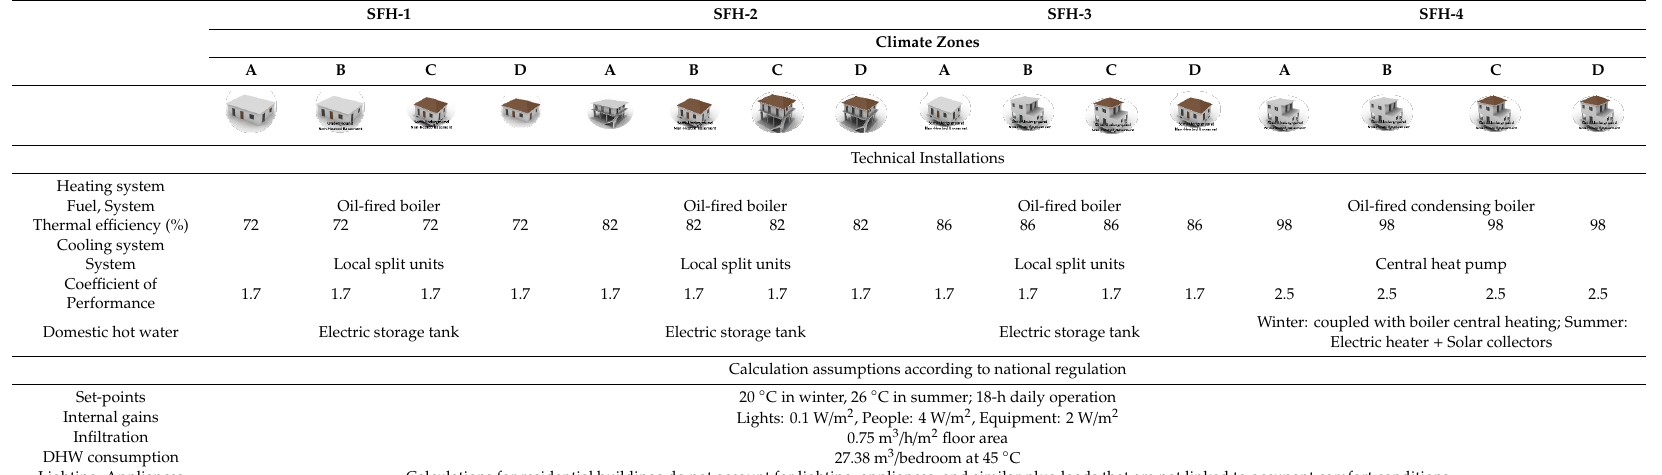
Table 1. Building and technical installation characteristics for 16 single-family houses (SFH) and other assumptions used in the calculations. SFH-1 SFH-2 SFH-3